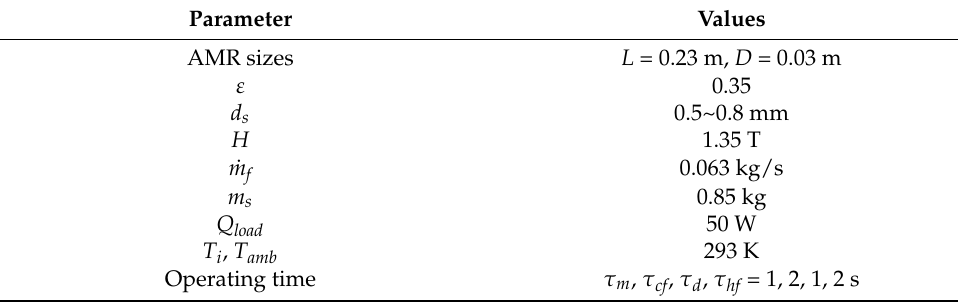
Table 2. AMR sizes and operating parameters of experiment.